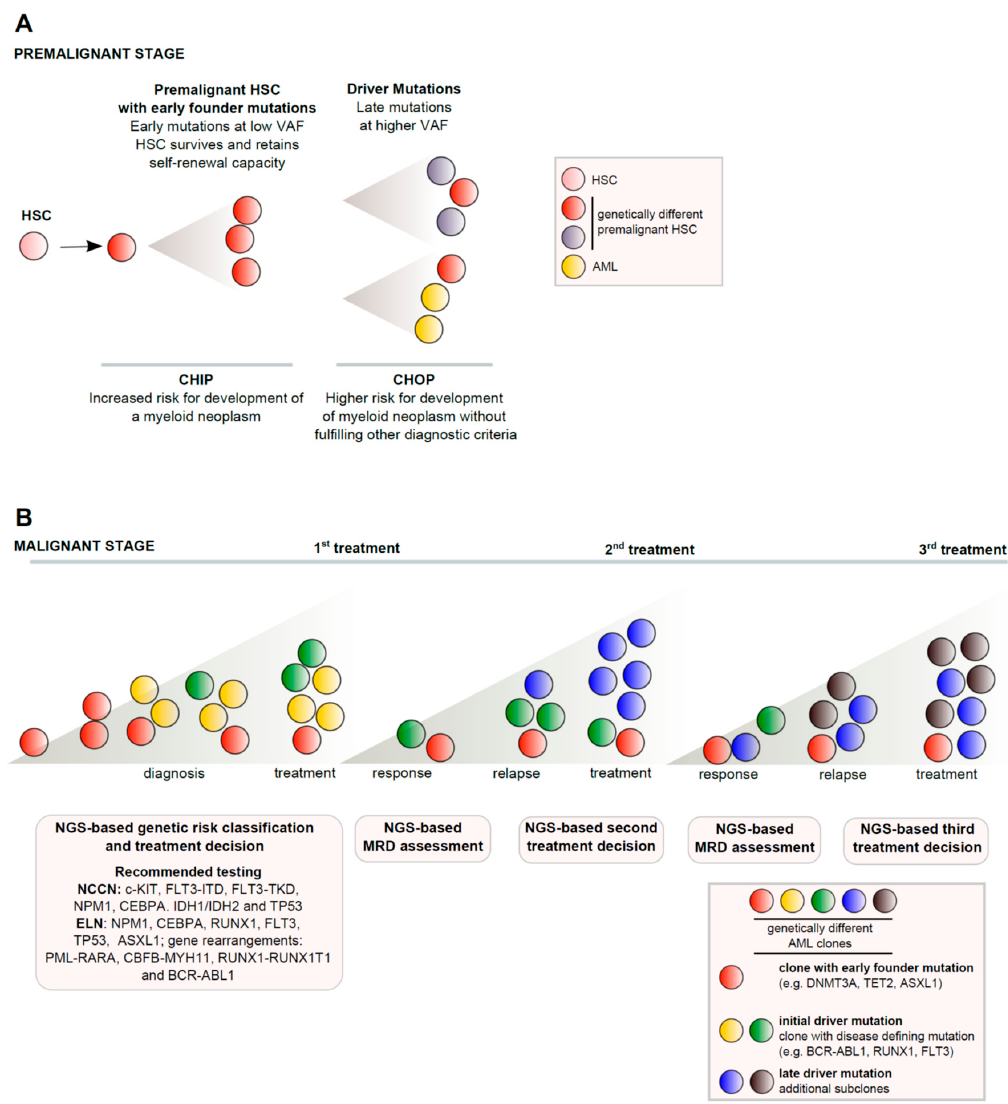
Figure 1. Pathogenesis of AML. ( A ) Premalignant stages preceeding to evolution of AML: early mutations in hematopoietic stem cells lead to clonal hematopoiesis (CHIP/CHOP) with genetically different premalignant stem cell subclones. ( B ) Subclonal genetic heterogeneity alongside AML development and progression is schematically depicted. NGS-based characterization of clonal and subclonal mutations is important for prognosis, treatment and response assessment (see text for explanations). HSC: Hematopoietic stem cell, VAF: Variant allelic frequency, CHIP: Clonal hematopoiesis of indeterminate potential, CHOP: Clonal hematopoiesis with substantial oncogenic potential, MRD: Minimal residual disease; NGS: Next generation sequencing, NCCN: National Comprehensive Cancer Network, ELN: European Leukemia Network.